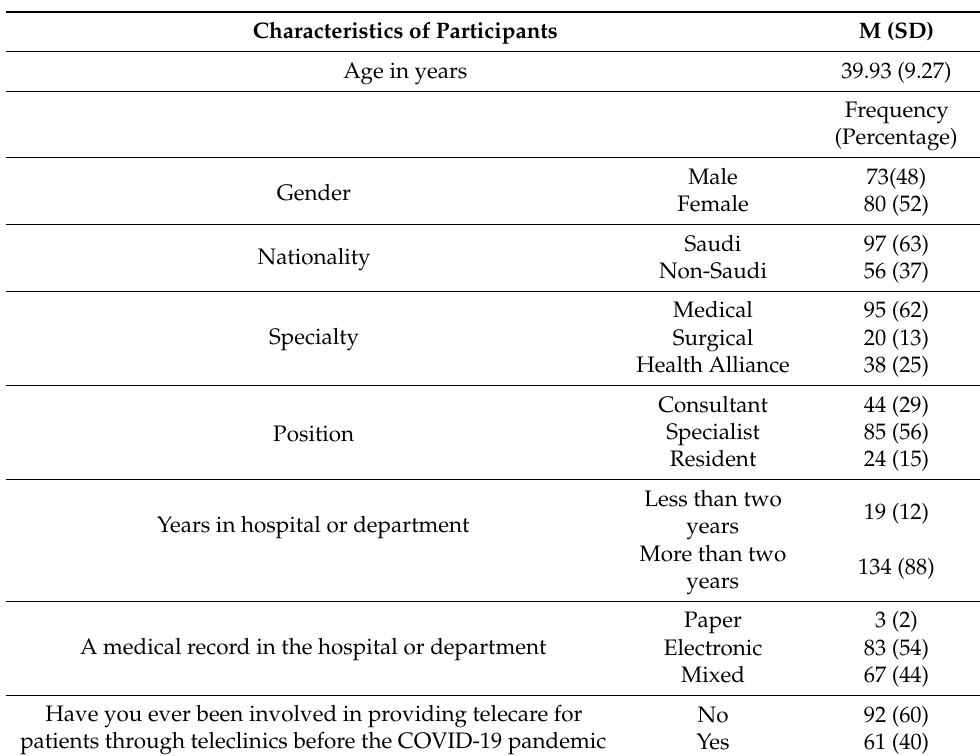
Table 1. Characteristics of